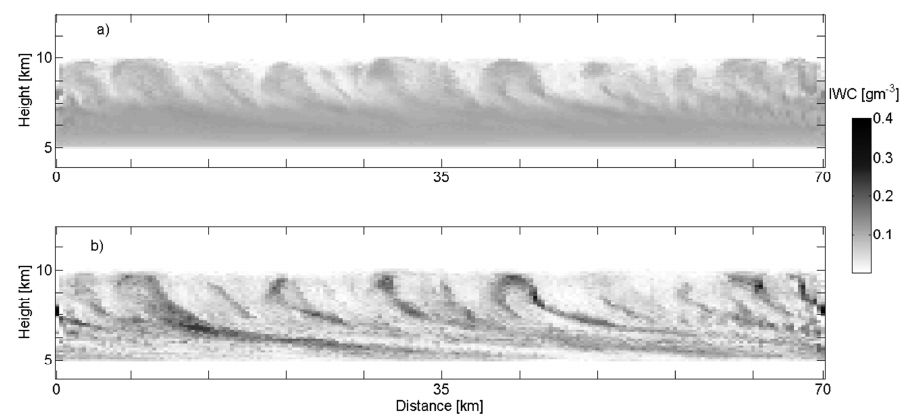
Figure 15. Same as Fig. 14b but after the second step of the algorithm, where 1-D spectral slope is close to − 5 / 3 from outer scale L out = 15km to the numerical scale 1x = 250m. (a) mean of 3-D IWC is IWC = 0 . 07gm − 3 and inhomogeneity parameter ρ IWC = 0 . 4 for cloudy voxels. (b) same as (a) but with inhomogeneity parameter ρ IWC , function of height and derived from the 27 December 1999 RADAR measurements between 10:00 and 12:00UTC crudely estimated from the Fig. 2c in Hogan and Kew (2005).